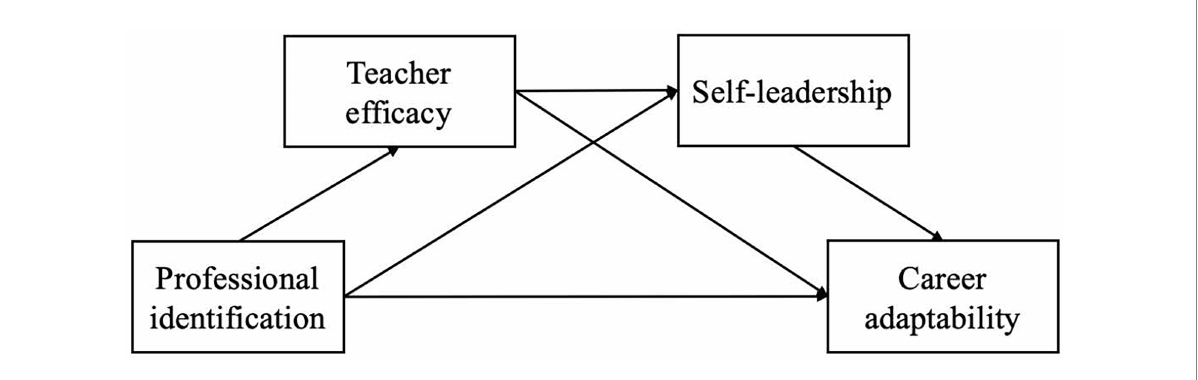
FIGURE 1 Hypothesized conceptual